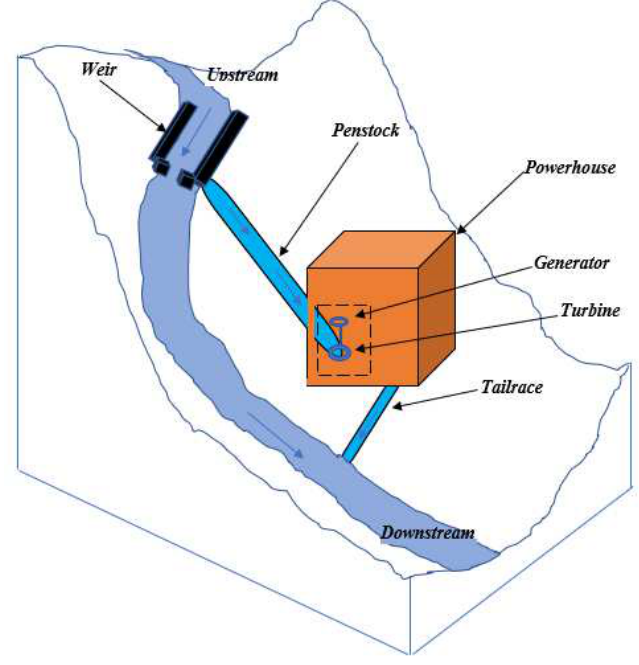
Figure 1. Site configuration of the model.